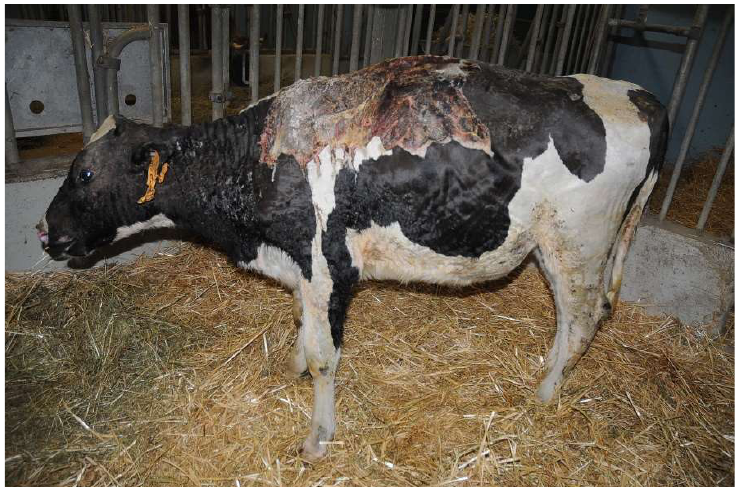
Figure 4. Heifer 1’s clinical appearance ten days after